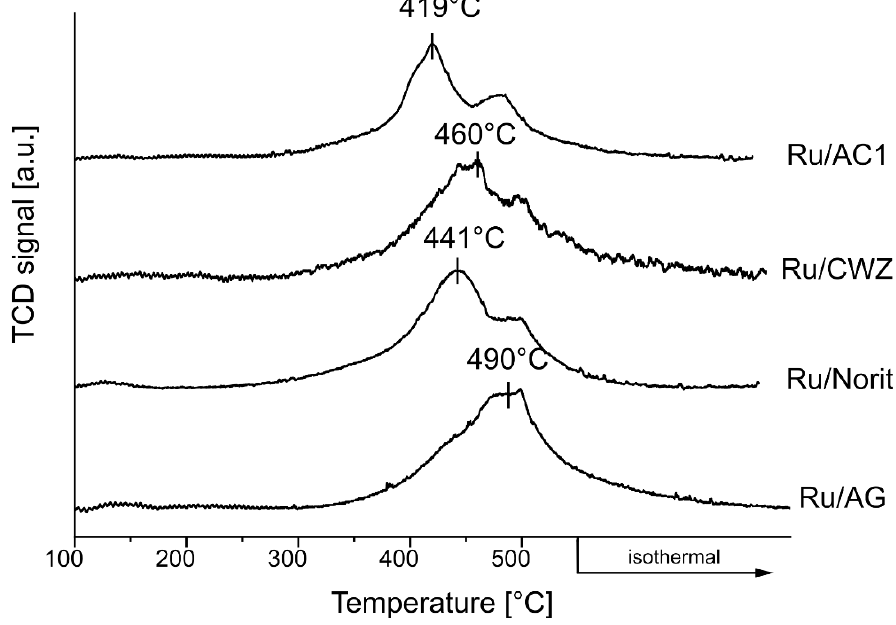
Figure 6. TPD-H 2 profiles of ruthenium catalysts.